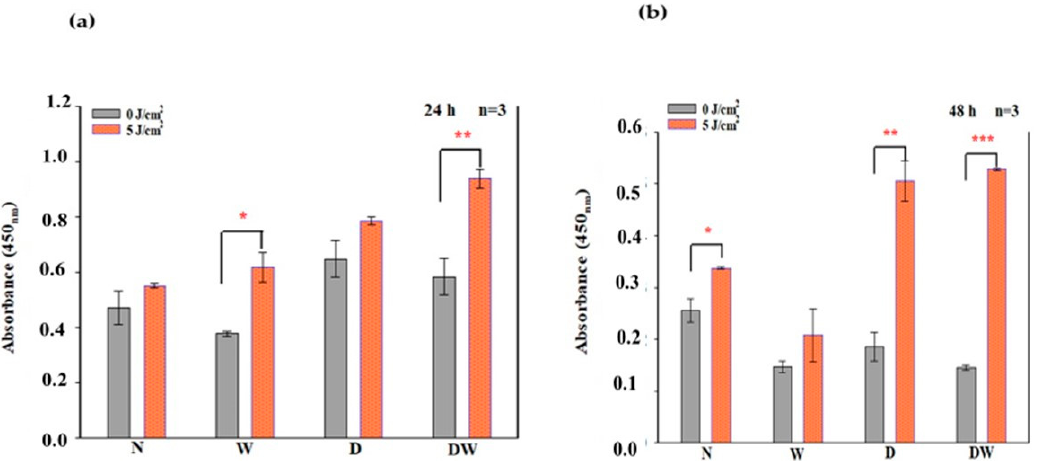
Figure 7. Phosphorylation (p-) of Ras-GFR1 as determined by ELISA in non- irradiated and irradiated normal (N), wounded (W), diabetic (D) and diabetic wounded (DW) cell models at 24 h ( a ) and 48 h ( b ) post-irradiation at 660 nm with a fluence of 5 J/cm 2 . Data are expressed as ± SEM (n = 3). Significant probabilities compared to the non-irradiated controls are shown as * p < 0.05, ** p < 0.01 and *** p < 0.001.